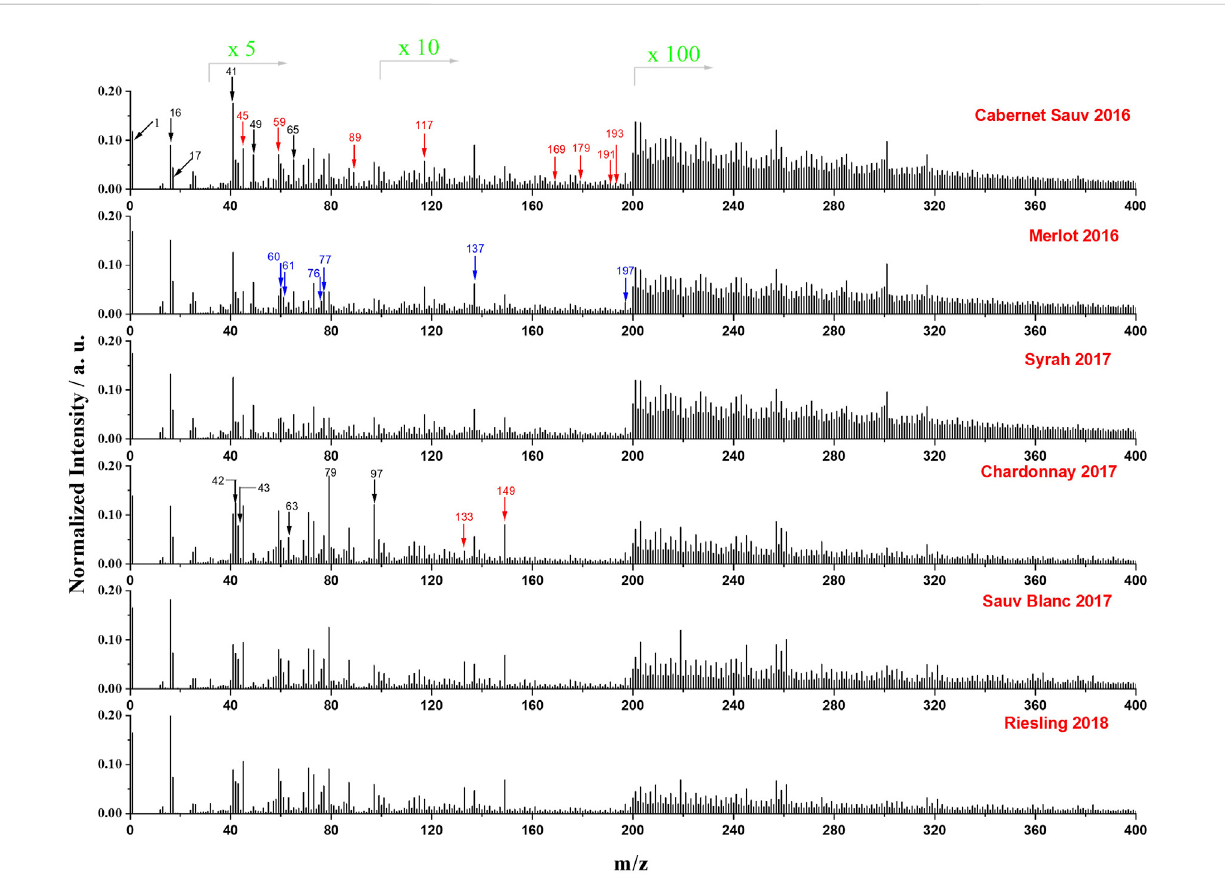
Normalized mass spectra (normalized to total intensity) of the six representative wines from a single manufacturer obtained by in situ liquid SIMS in negative mode. The intensity of peaks in the range of m/z 30 to 100, 101 to 199, and 200 to 400 was ampli fi ed by 5 times, 10 times, and 100 times, respectively. Cabernet Sauvignon 2016, Merlot 2016 and Syrah 2017 are red wines, and Chardonnay 2017, Sauvignon Blanc 2017 and Riesling 2018 are white wines. Organic acid species are indicated by red arrows, SiO x signals from SiN membraneare indicated with blue arrows, and other species of interest are indicated by black